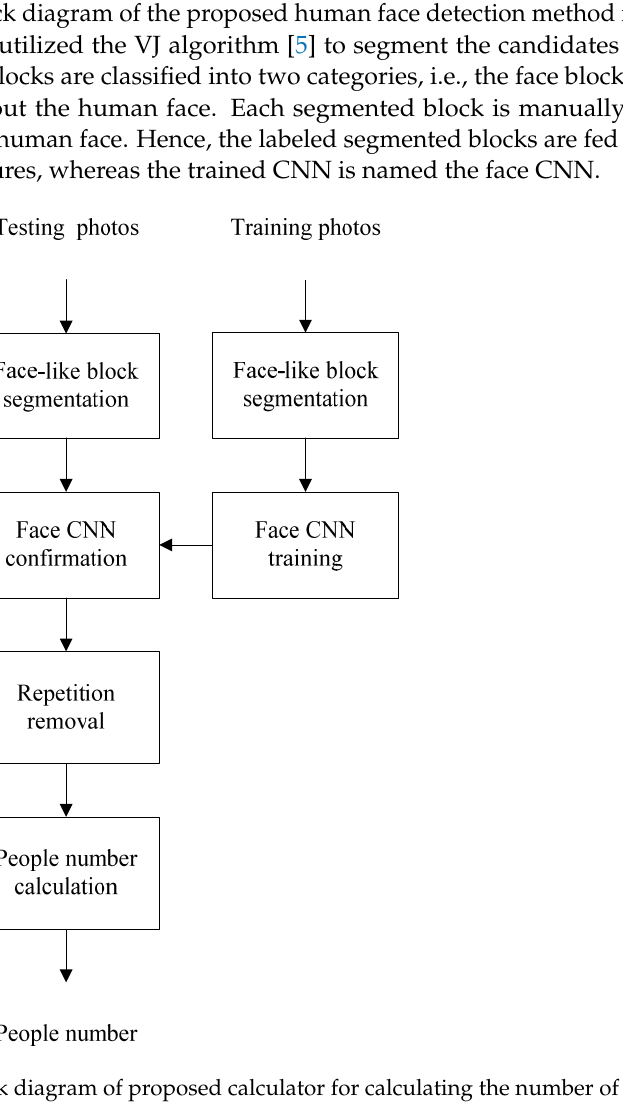
Figure 2. Block diagram of proposed calculator for calculating the number of people in a